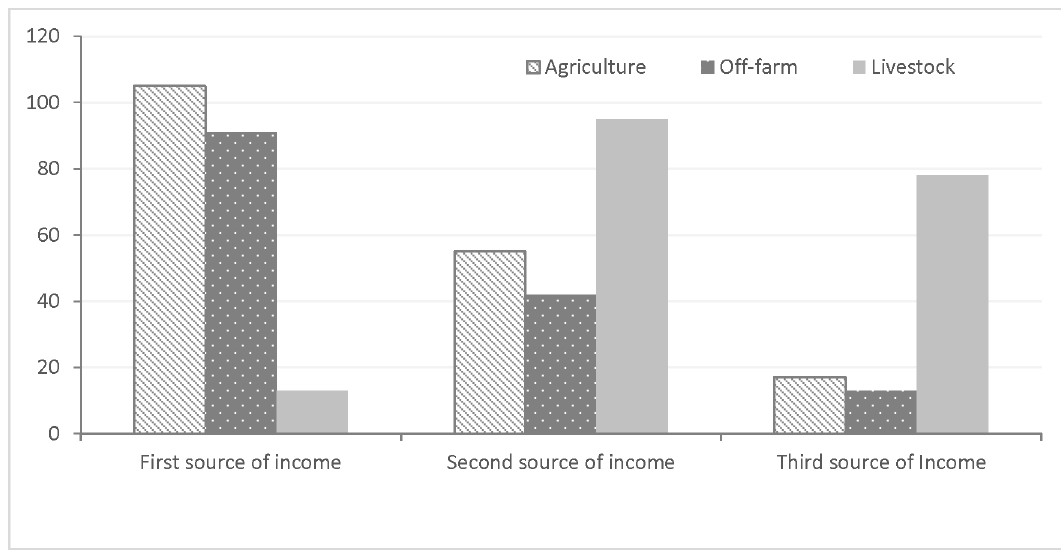
Fig 7. Dependency of livestock depredation victim households on agriculture, livestock and other off-farm